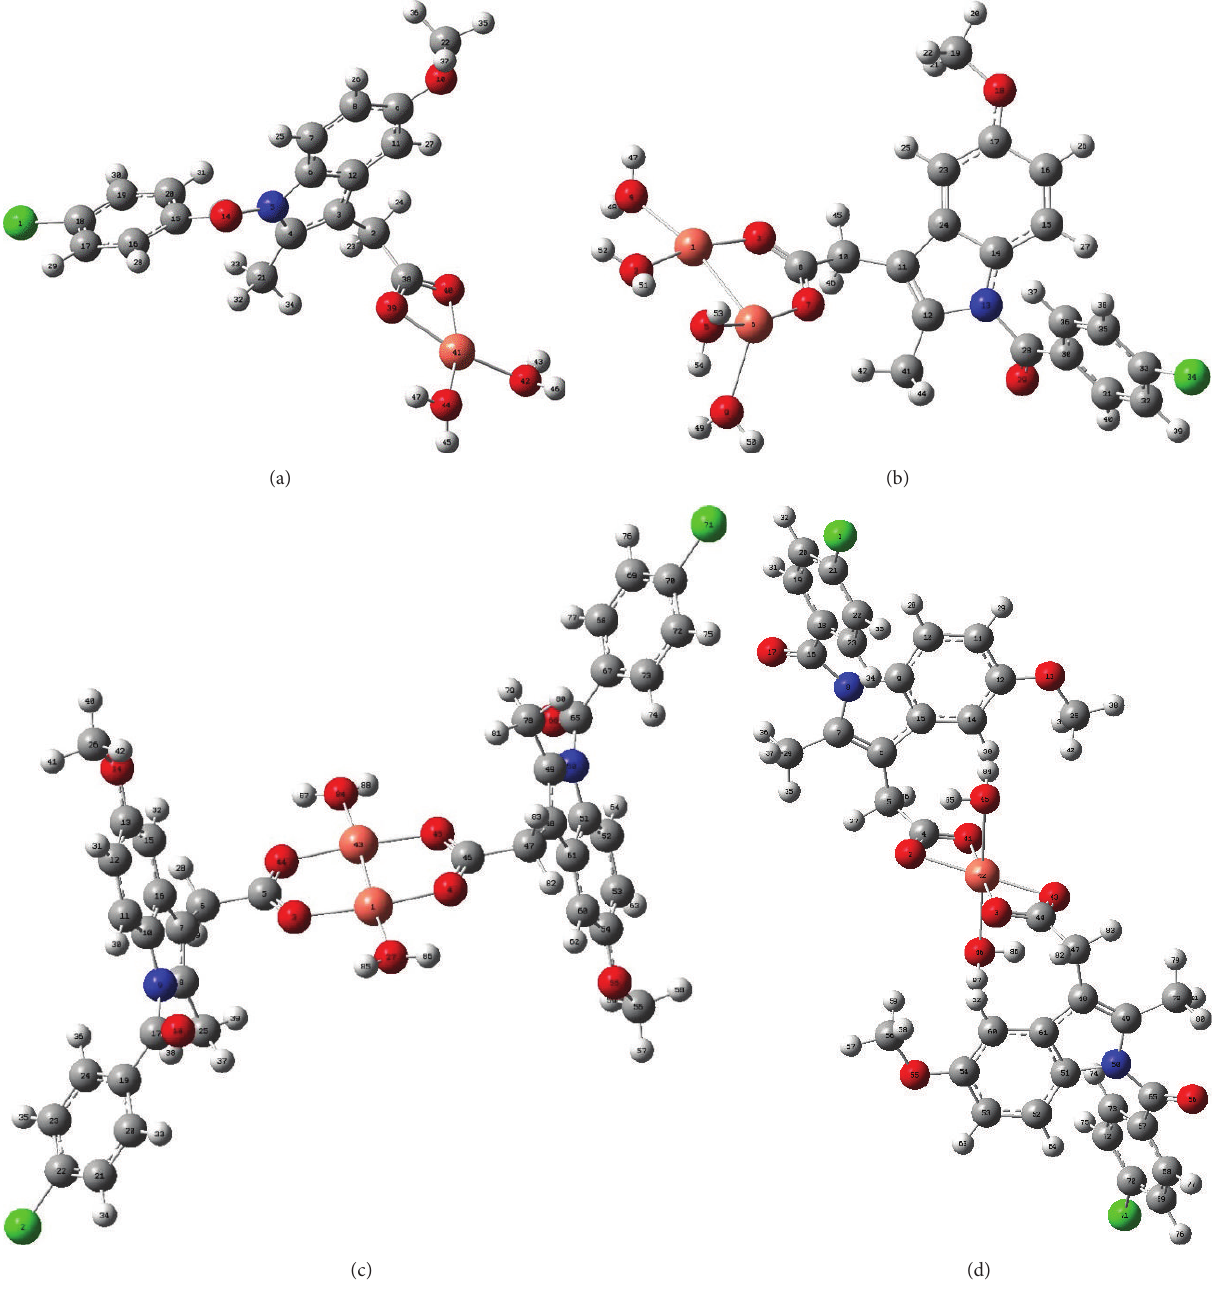
Figure 14: Determined molecular structures using theoretical methods for (a) CuIndo + , (b) Cu 2 Indo 3+ , (c) Cu 2 Indo 22+ , and (d) CuIndo 2